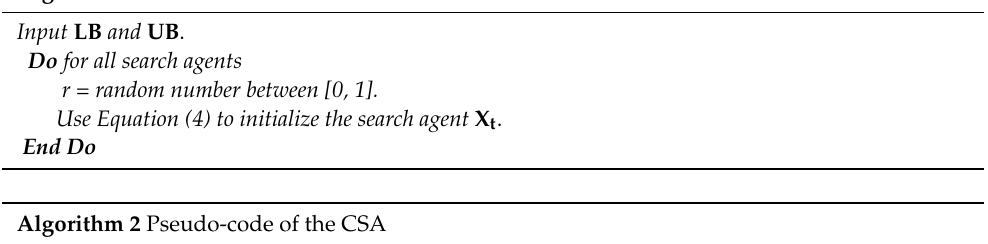
Algorithm 2 Pseudo-code of the CSA Initialize the search agents X t using Algorithm